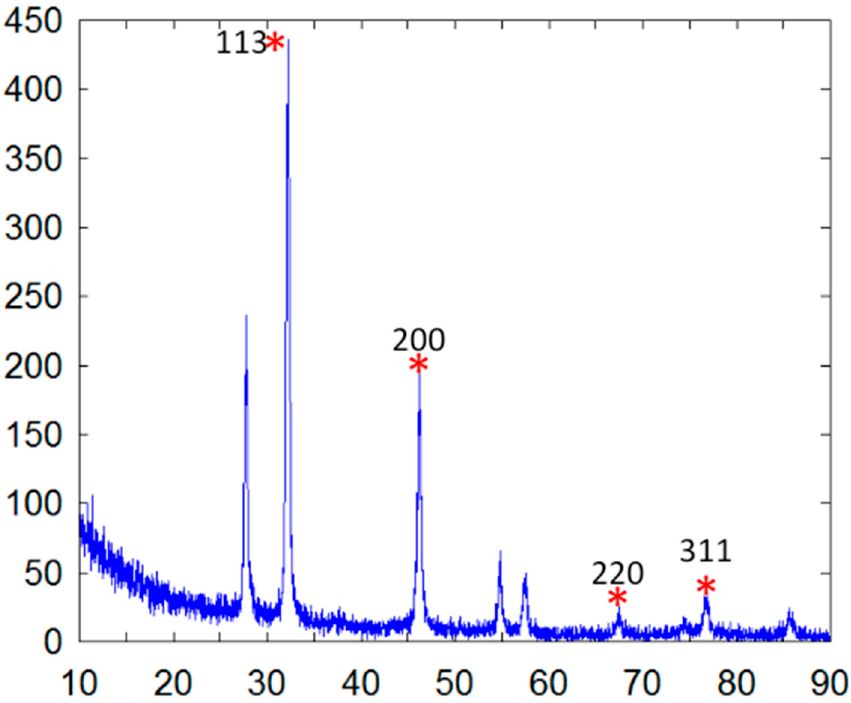
Figure 4. X-ray diffraction pattern of synthesized AgNPs. Ag peaks are marked (*) and 2 θ values are given.